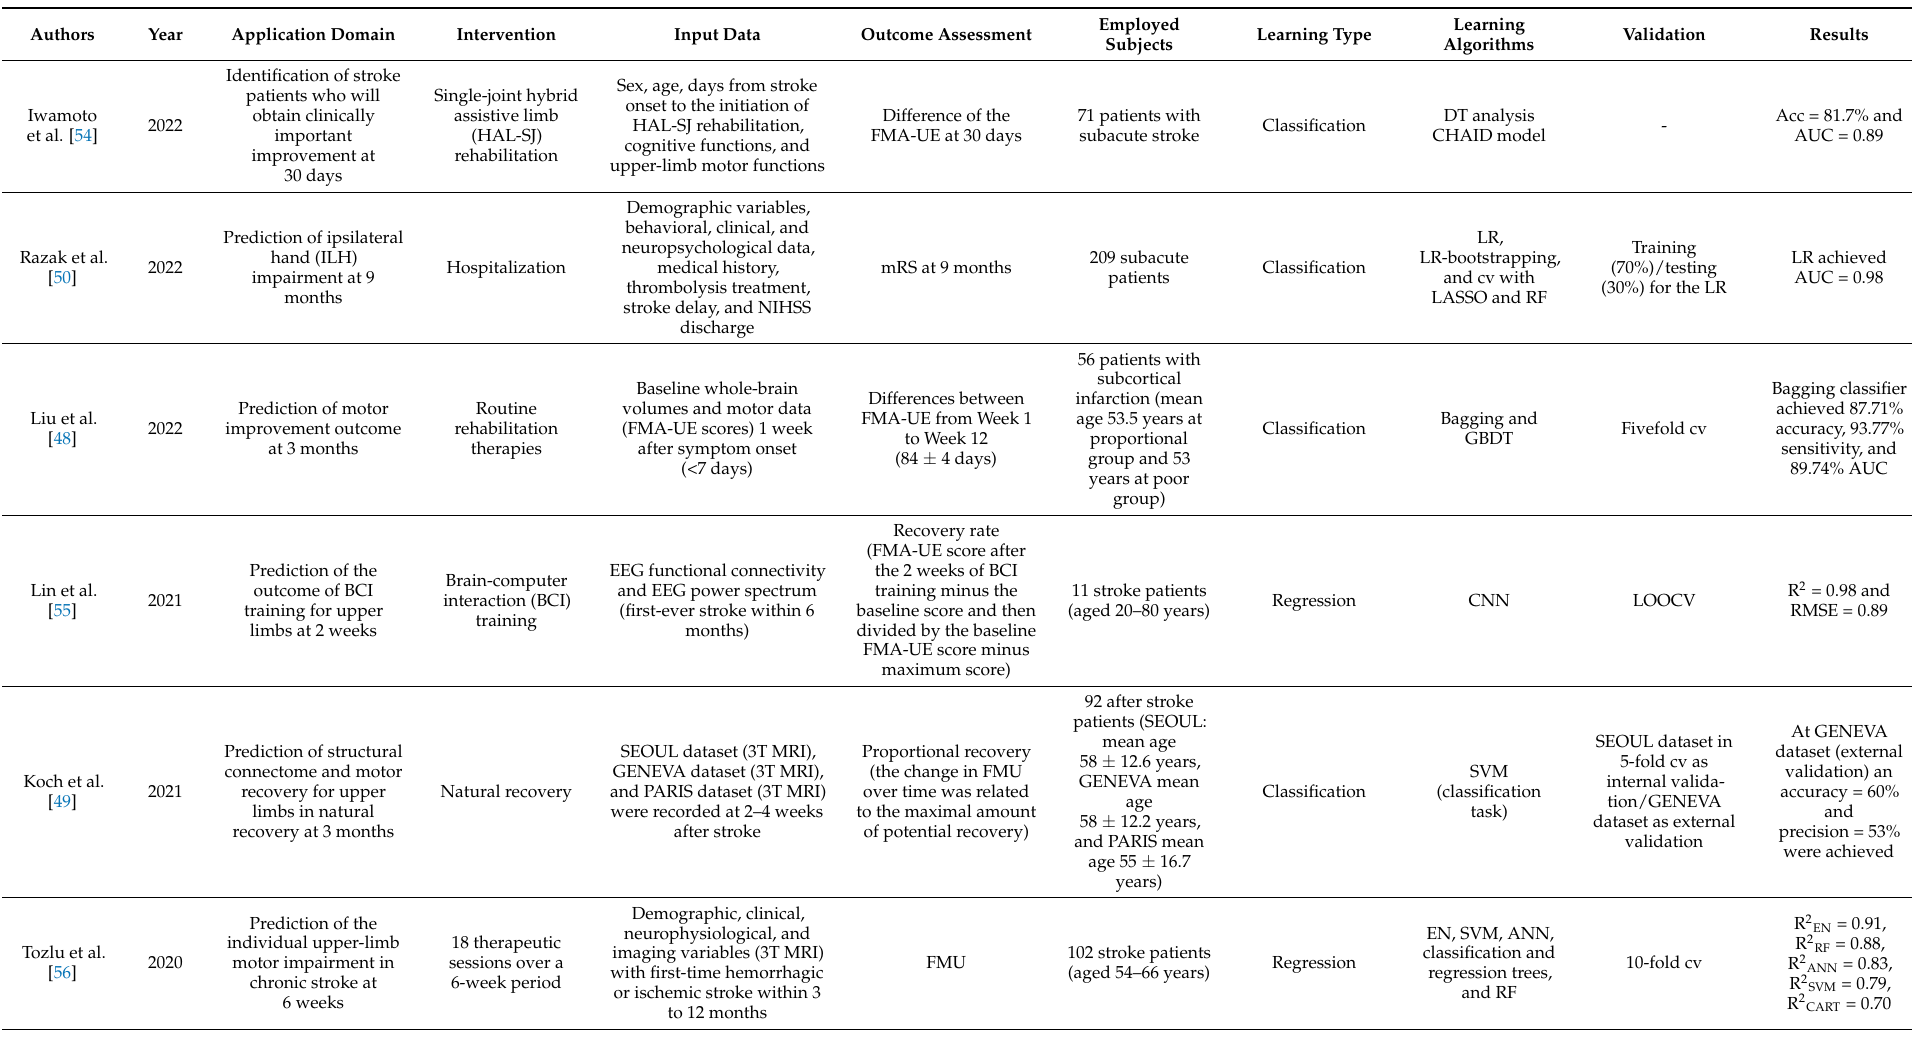
Table 2. Findings and characteristics of included ML studies for upper extremities